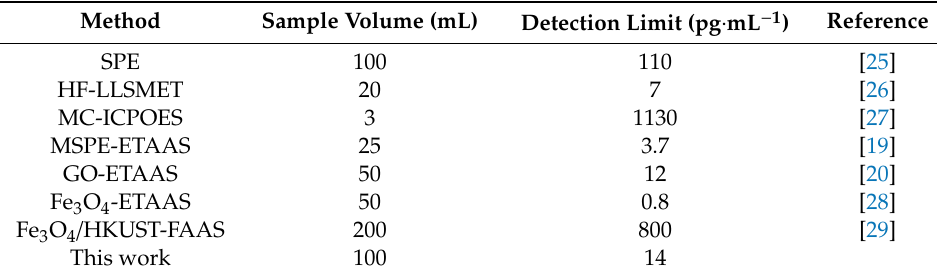
Table 1. Comparison of the present method with the other methods.